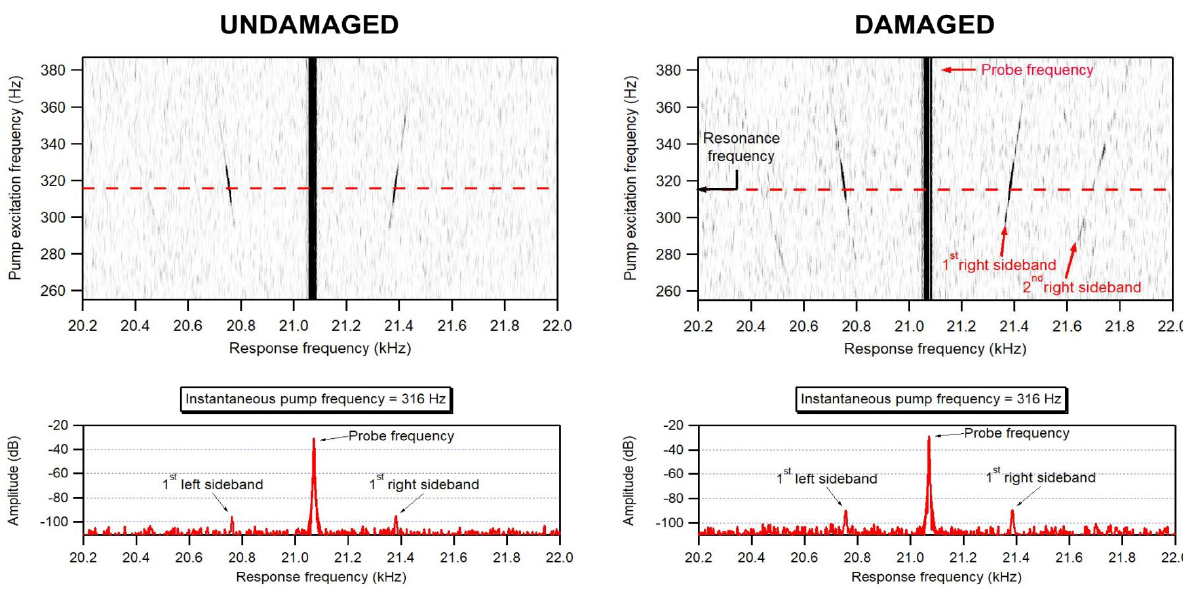
Figure 9. Spectrograms of the response of the beam to a swept pump excitation (frequency range 255–390 Hz) in the undamaged ( left ) and damaged ( right ) conditions. The graphs of the bottom row plot the response spectra extracted from the spectrograms at the instantaneous pump frequency of 316 Hz (shown by the dotted red line in the spectrograms).